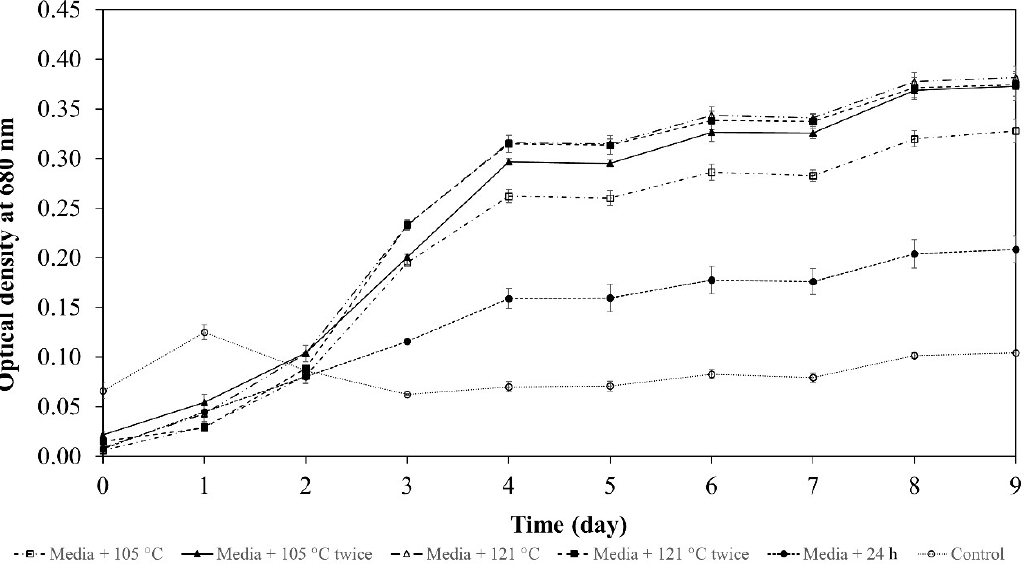
Figure 4. Optical density at 680 nm of Chlorella sorokiniana . Error bars represent the standard deviation between three replicates ( n = 3).